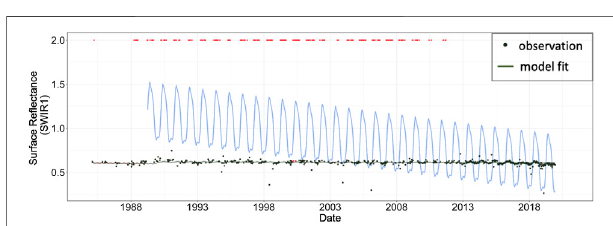
FIGURE10| Thetime seriesplotofusingthebaselineobservationsto fi t the model (only QA band fi ltering; red dots with red/blue curves) versus the saturation fi ltering (black dots and black curves) (Lat: 21.7886; Lon: 31.8935).